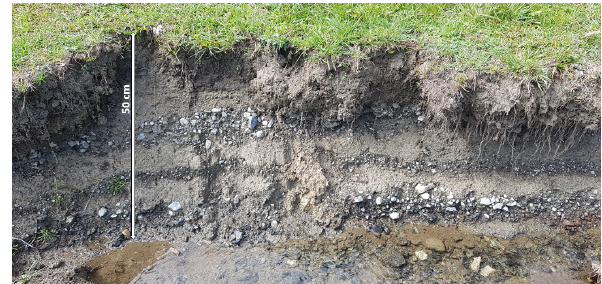
Figure 5. Representative photograph of the trench (see Fig. 2 for location), showing the uppermost 50cm thick sedimentary succes- sion. Though the exposure is quite small, the graded pebble–sand couplets belonging to Unit 5 can be interpreted as a sheet-flood de-